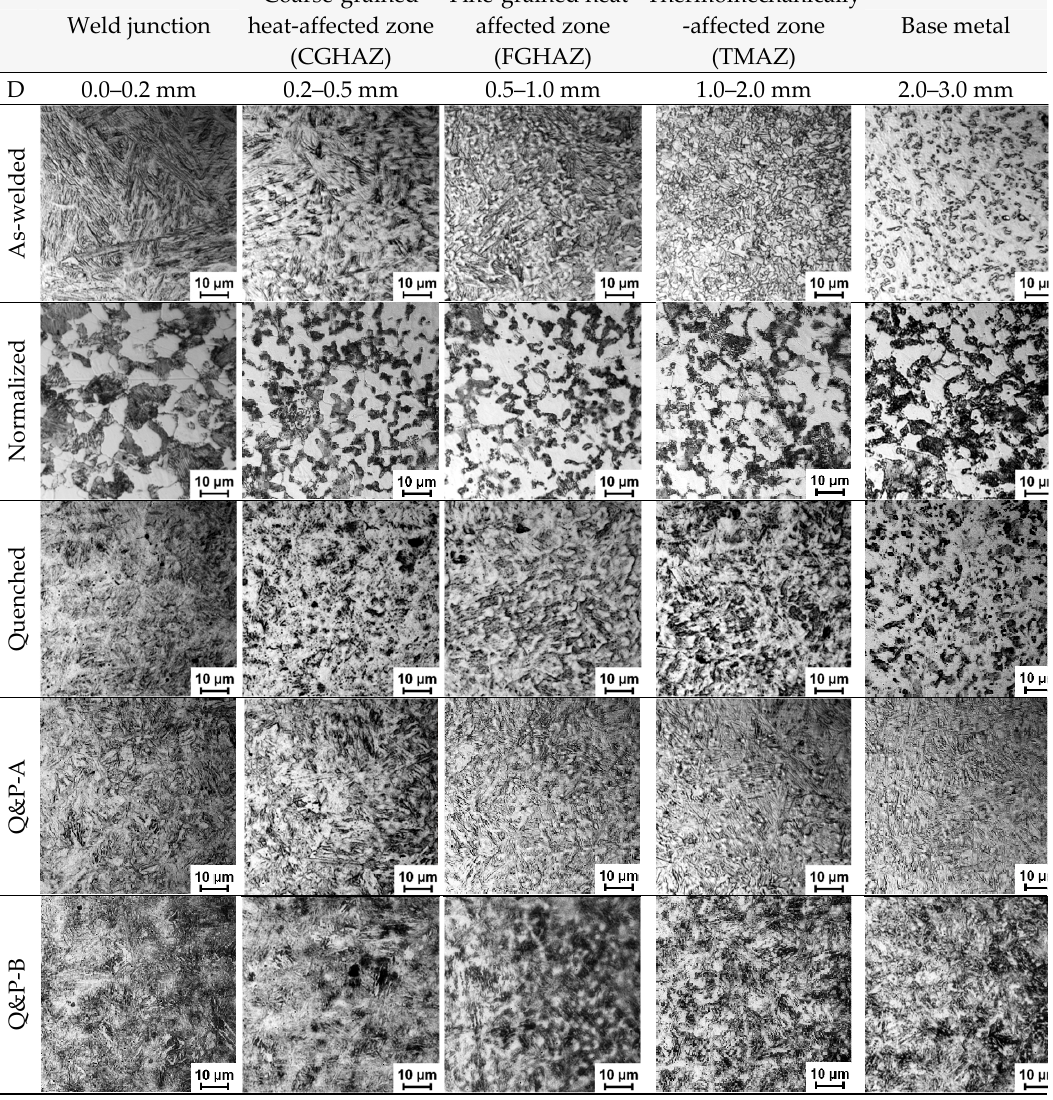
Figure 7. Optical micrographs of different 42SiCr samples after HFI welding and heat treatment at different distances (D) along the neutral axis from the joint.